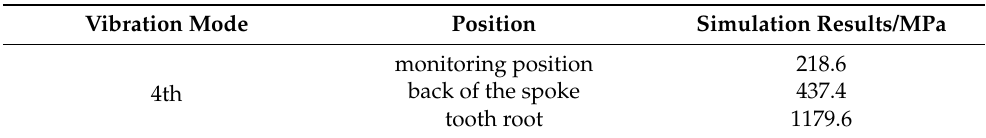
Figure 19. Spoke equivalent stress of driven bevel gear at the 4th ND resonant rotational speed: ( a ) The stress concentration position on the back of the spoke plate; ( b ) The stress concentration position at the tooth root. Table 12. Different positions equivalent stress of driven bevel gear at the 4th ND resonant rotational speed.